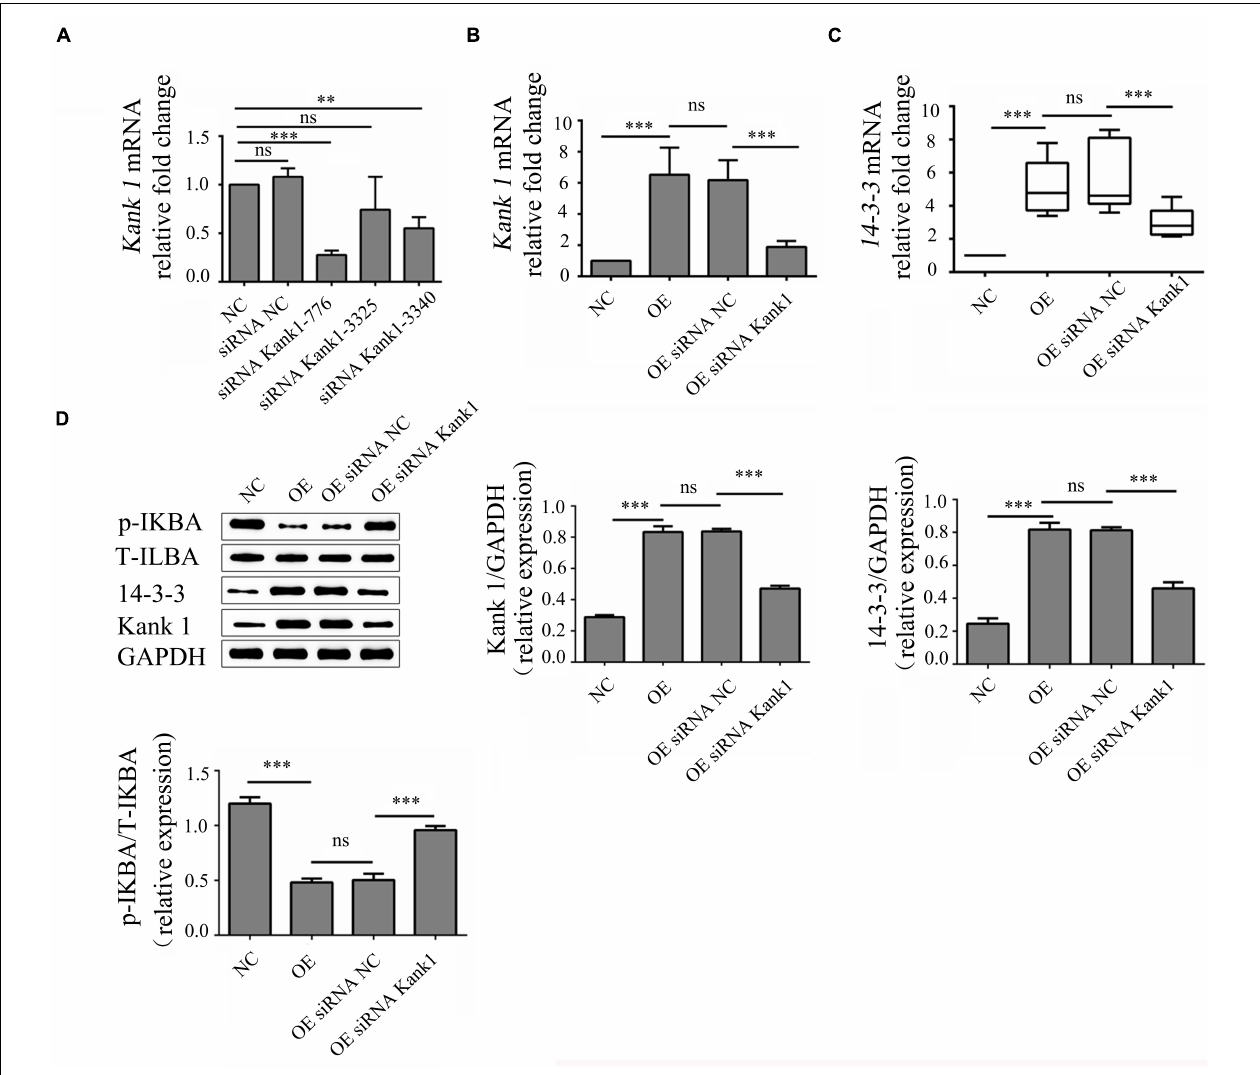
FIGURE 4 | LncRNA-ENST00000421645 promoted the protein expression of Kank1 and 14-3-3 and inhibited NF-kB pathway activation. (A) The Kank1 gene knockdown efficiency of dKank1 siRNA in T lymphocytes was evaluated by RT-qPCR, and the siRNA with the highest efficiency— Kank1-776 —was selected. (B) The relative mRNA level of Kank1 in NC cells, OE cells, OEsiRNA NC cells, and OEsiRNA Kank1 cells was determined by RT-qPCR. (C) The relative mRNA level of 14-3-3 in NC cells, OE cells, OEsiRNA NC cells, and OEsiRNA Kank1 cells was determined by RT-qPCR. (D) The protein levels of p-IKBA, T-IKBA, 14-3-3 and Kank1 in NC cells, OE cells, OEsiRNA NC cells and OEsiRNA Kank1 cells were determined by Western blot analysis ( ∗∗ P < 0.01, ∗∗∗ P < 0.001). 14-3-3 mRNA level was analyzed by using rank sum test. The multiple comparison of 14-3-3 expression level was conducted using Kruskal-Wallis test. Kank1 mRNA and protein level of p-IKBA, T-IKBA, 14-3-3 and Kank1 were analyzed by using One-way ANOVA, and SNK test was used for conducting multiple comparison. P -values less than 0.05 were considered statistically significant.